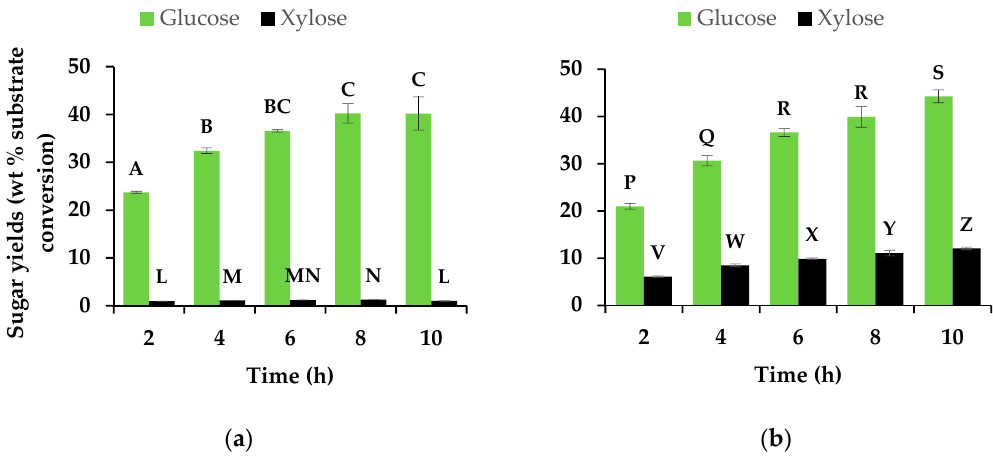
Figure 1. Glucose and xylose yields from cellulase cocktail treatment of ( a ) filter paper and ( b ) wood pulp over a time period of 2–10 h. Bars that are denoted by non-identical letters within each yield data are significantly different ( p < 0.05). The cellulase loading for filter paper treatment was calibrated to 1.7 fold higher relative to wood pulp to ensure that enzyme concentration is not a limiting factor based on dosage response curve analysis.